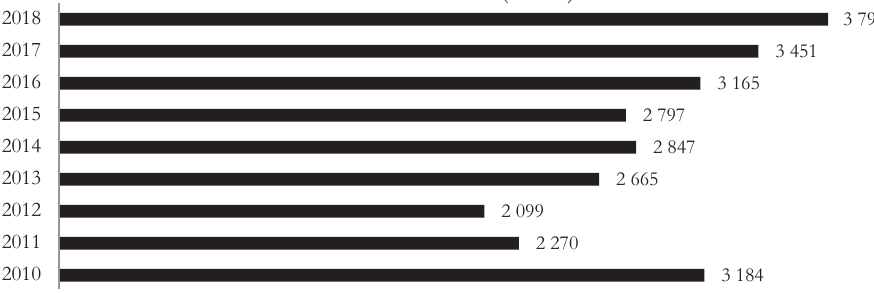
Fig. 2 – Foreign Direct Investment in Pakistan (2010-2018). Source: State Bank of Pakistan